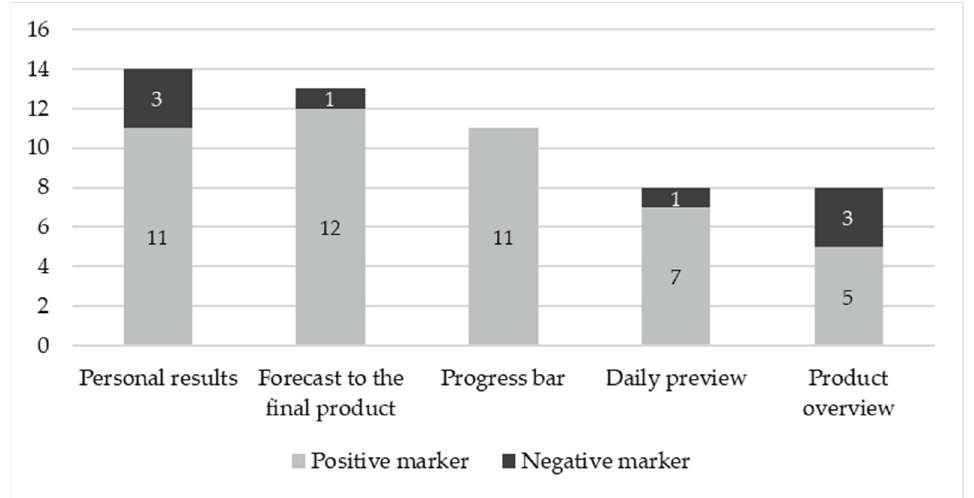
Figure 6. Absolute frequency of positive and negative valence markers of design elements in redesigned WGS prototype that received the most valence markers.